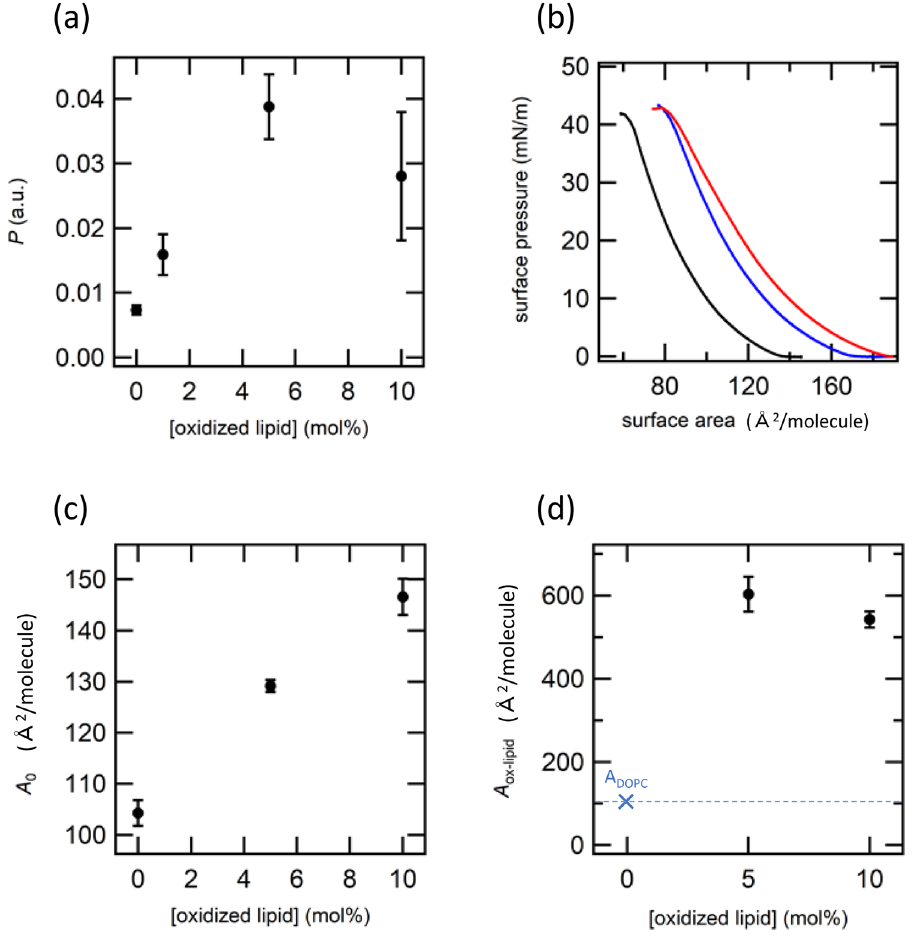
Figure 5. Data for PazePC. The permeation rate P as the function of the concentration of PazePC. ( b ) π – A curves of DOPC/PazePC monolayers. The concentrations of 9COOH-PC are 0 (black), 5 (blue), and 10 (red) mol %. ( c ) Averaged limiting area ( A 0 ) estimated from π – A curves as the function of the concentration of PazePC. ( d ) Calculated limiting area of oxidized lipid ( A ox-lipid ) as the function of the concentration of